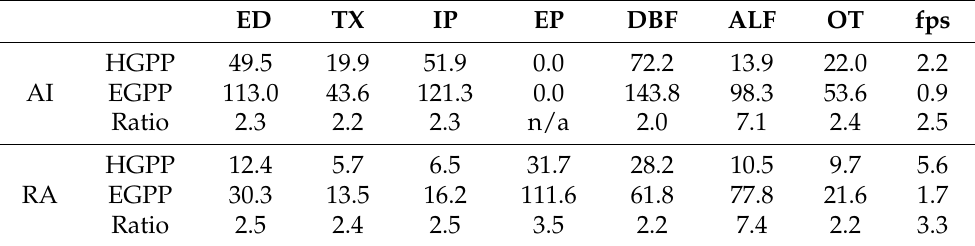
Table 4. Average processing times (in secs) for each decoding block, average global fps achieved and ratio between HGPP and